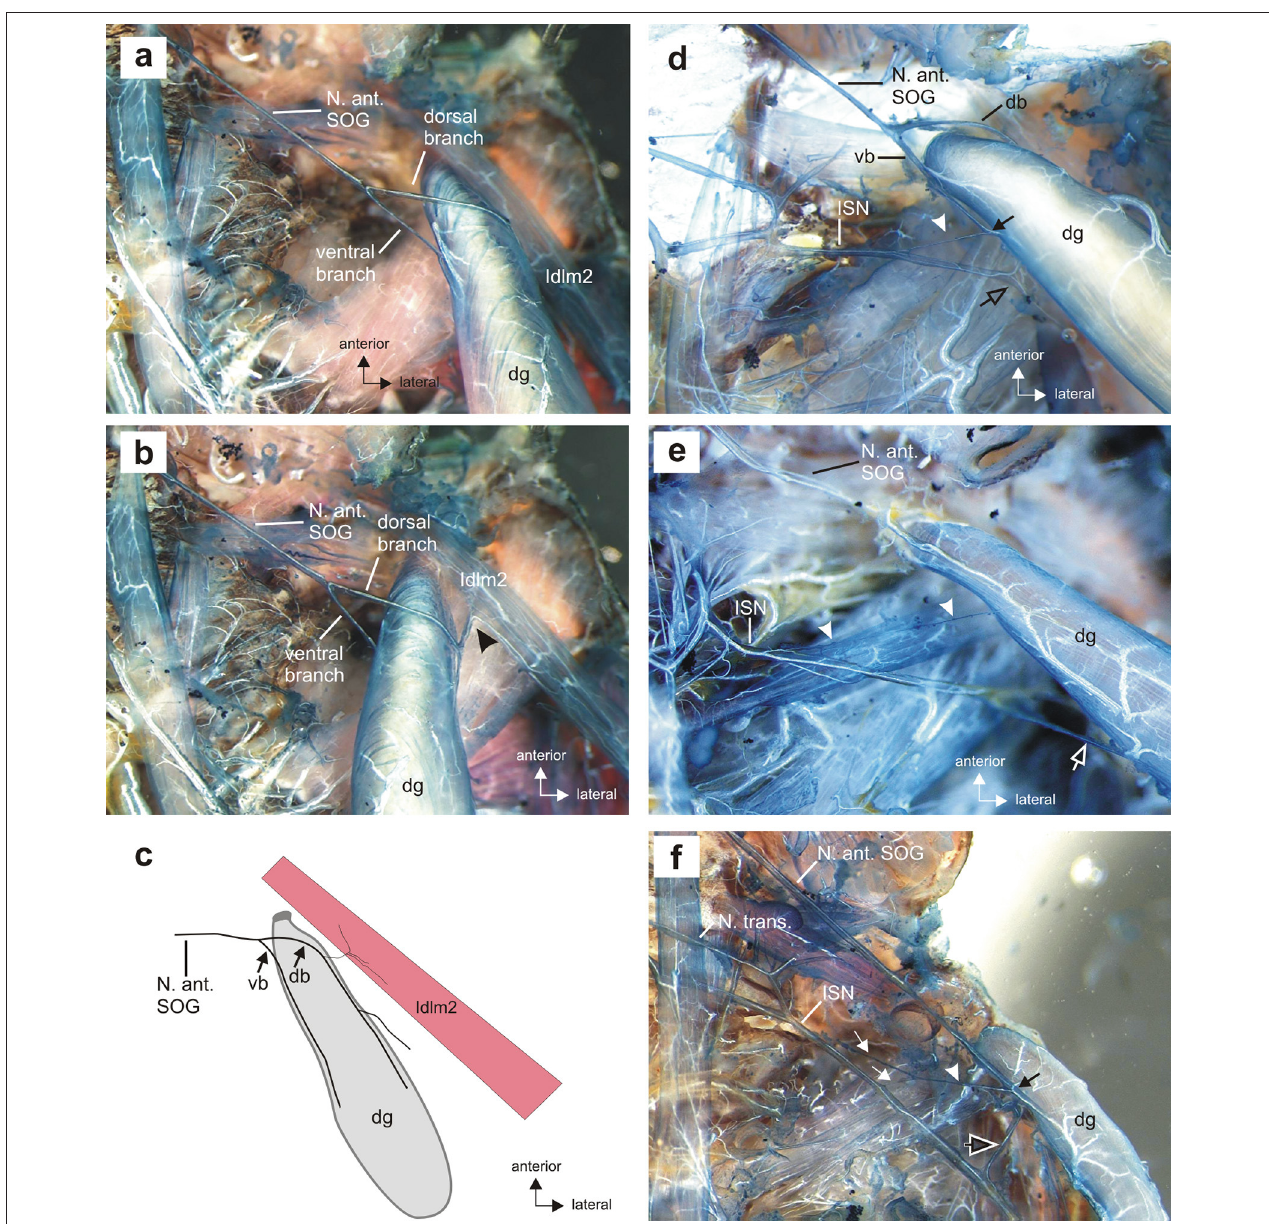
FIGURE 5 | Details of the gland innervation in situ . (a) Innervation of the defense gland (dg) by two branches of the N. anterior SOG, the dorsal and ventral branch, in dorsal view. (b) The dorsal branch innervates both the defense gland by the larger dorsal branch contacting the gland muscle and a dorsal longitudinal muscle (Idlm2) in the prothorax by a short side branch (black arrowhead), apparent with defense gland turned medially. Longitudinal neck muscle Idlm1 was removed during preparation. (c) Schematic of the shared innervation of dorsal longitudinal muscle (Idlm2) by the dorsal branch of the N. anterior SOG; the ventral branch exclusively innervates the defense gland. (d) The intersegmental nerve complex (ISN) usually contacts the defense gland by a fine nerve branch (white arrowhead). The ventral nerve branch (vb) and the nerve branch from the ISN connect at the gland surface (black arrow). The ISN extends laterally of the defense gland toward a longitudinal muscle, Idlm1 (black open arrow). (e) A second contact from the ISN can occur further distally on the gland surface (white open arrow). White arrowheads indicate the fine branch in more anterior position. (f) Two fine branches of the ISN (white arrows) can merge before contacting the gland as a single fiber (white arrowhead), with a shared contact zone with the N. anterior SOG (black arrow) on the gland surface. Note the ISN extending laterally toward the longitudinal muscle Idlm1 (black open arrow). db, dorsal branch of Nervus anterior SOG; dg, defense gland; dlm, dorsal longitudinal muscle; ISN, intersegmental nerve complex; N. ant. SOG, Nervus anterior of the subesophageal ganglion; N. transv., Nervus transversus; vb, ventral branch of N. anterior SOG.